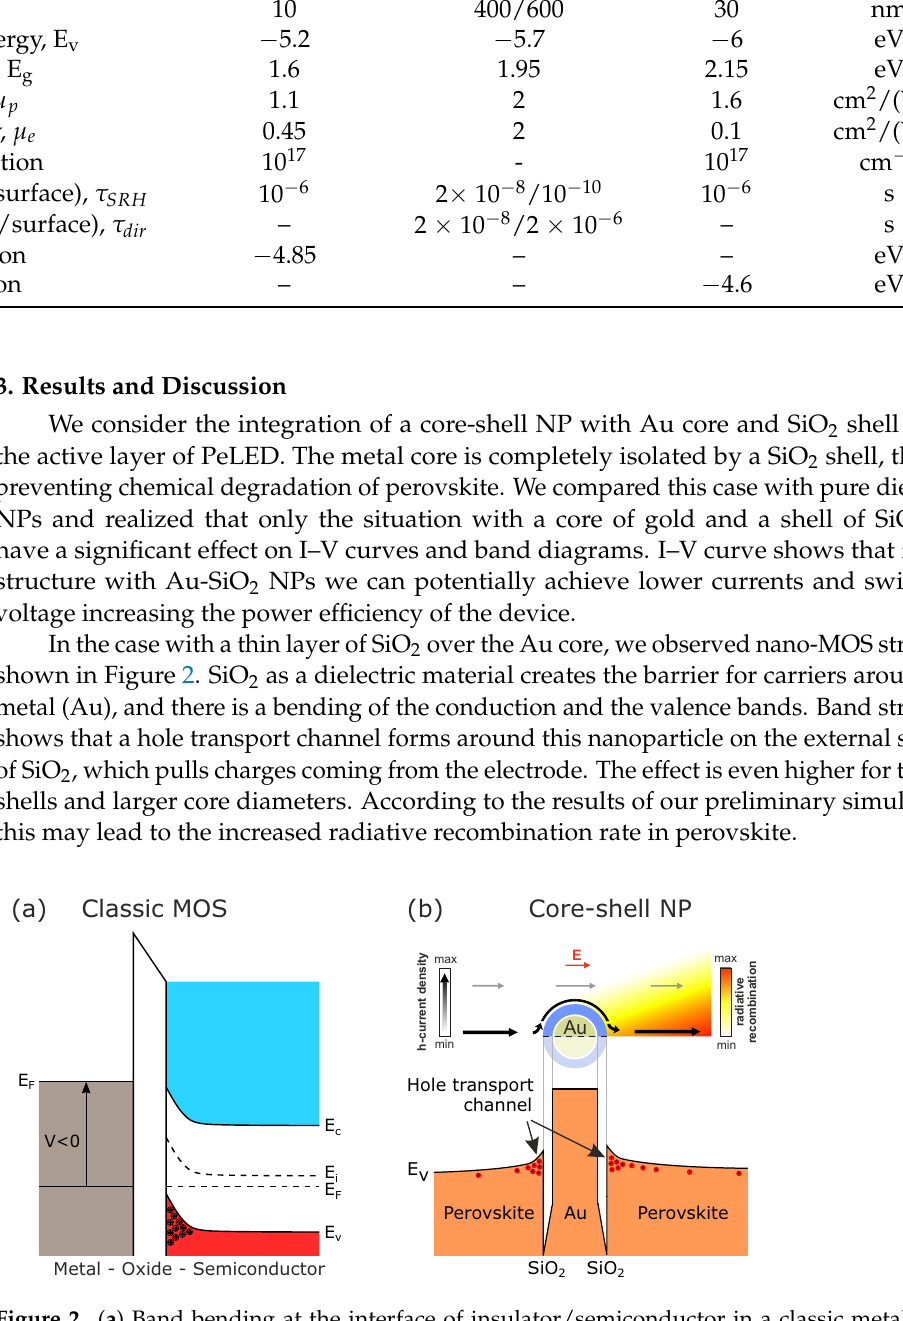
Figure 2. ( a ) Band bending at the interface of insulator/semiconductor in a classic metal-oxide- semiconductor (MOS) structure. ( b ) Valence band profile with formation of hole transport channel around the surface of NP which leads to the increased radiative recombination rate in perovskite.